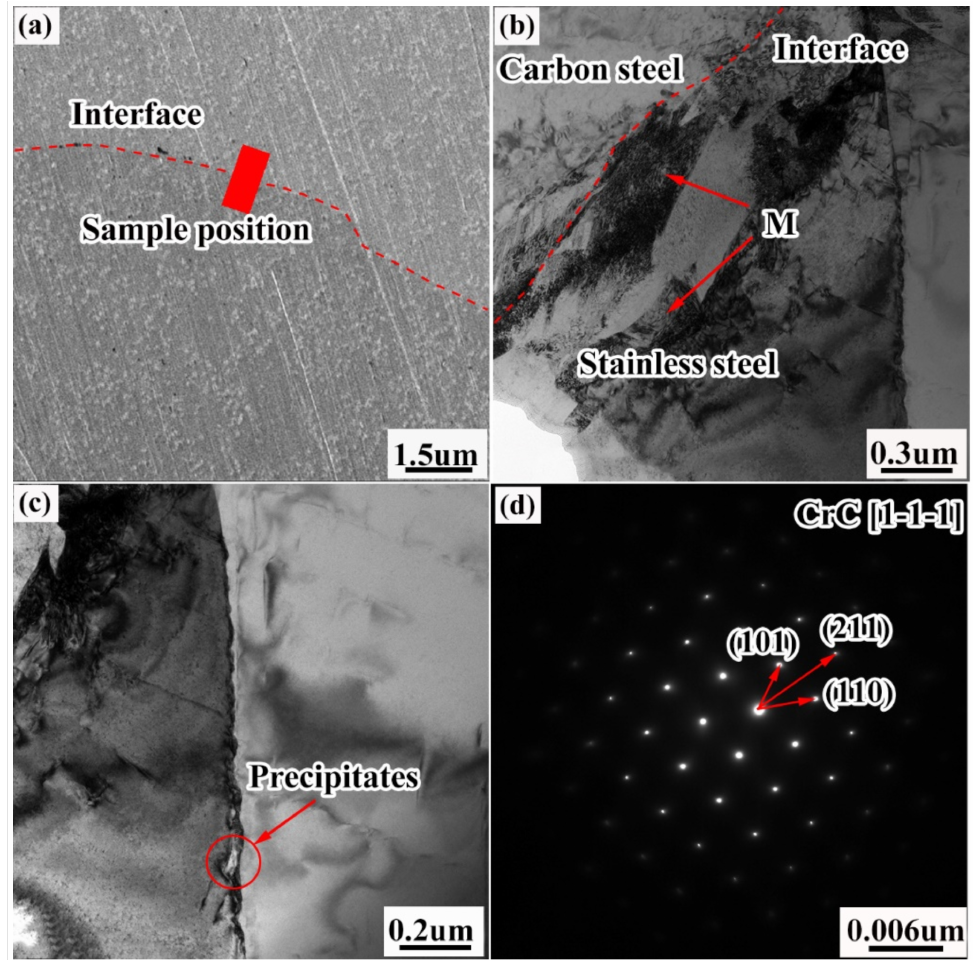
Figure 11. TEM images showing the microstructure of the composite interface: ( a ) transmission sampling position; ( b ) bright-field TEM image of the composite interface; ( c ) microscopic morphology of the stainless steel grain-boundary precipitates; ( d ) electron-diffraction image of the